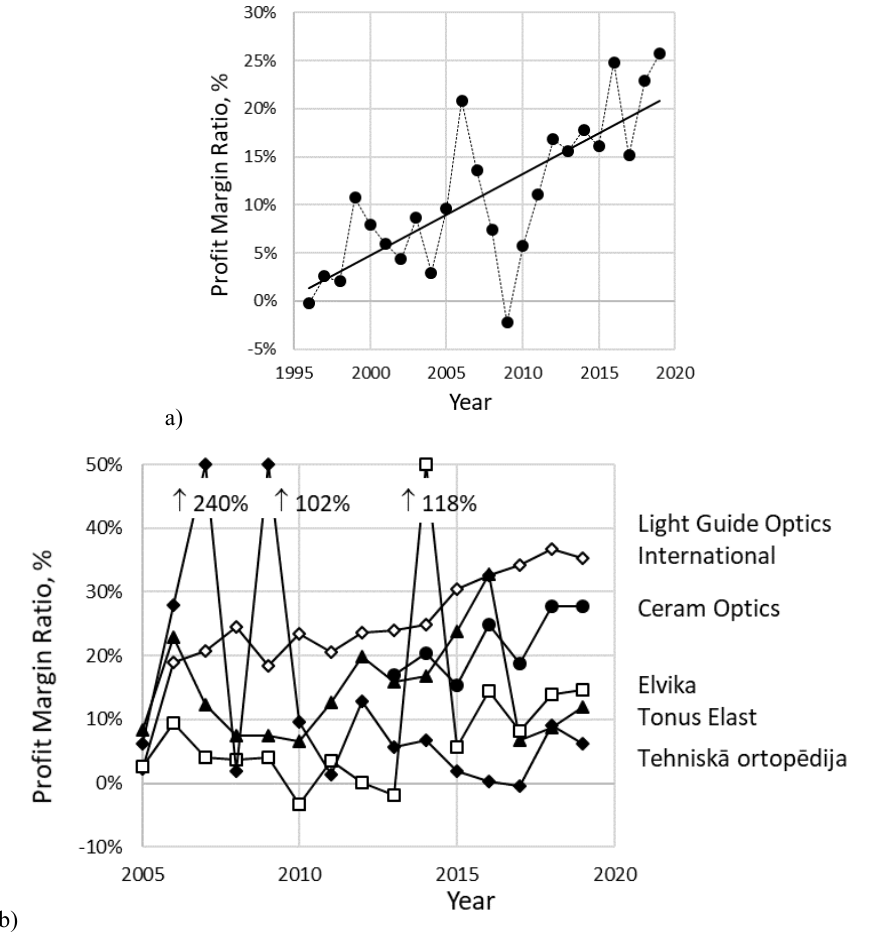
Fig. 9. Profit margin ratio in the MD manufacturing sector in Latvia (the author’s